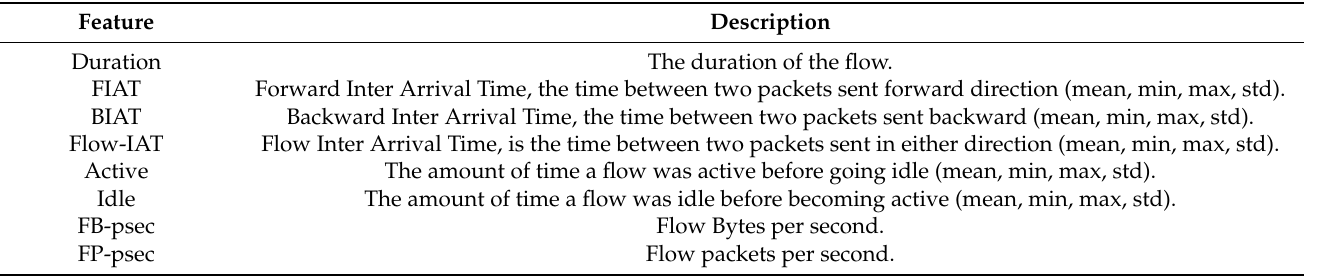
Table 2. The time-related features and their descriptions. Feature